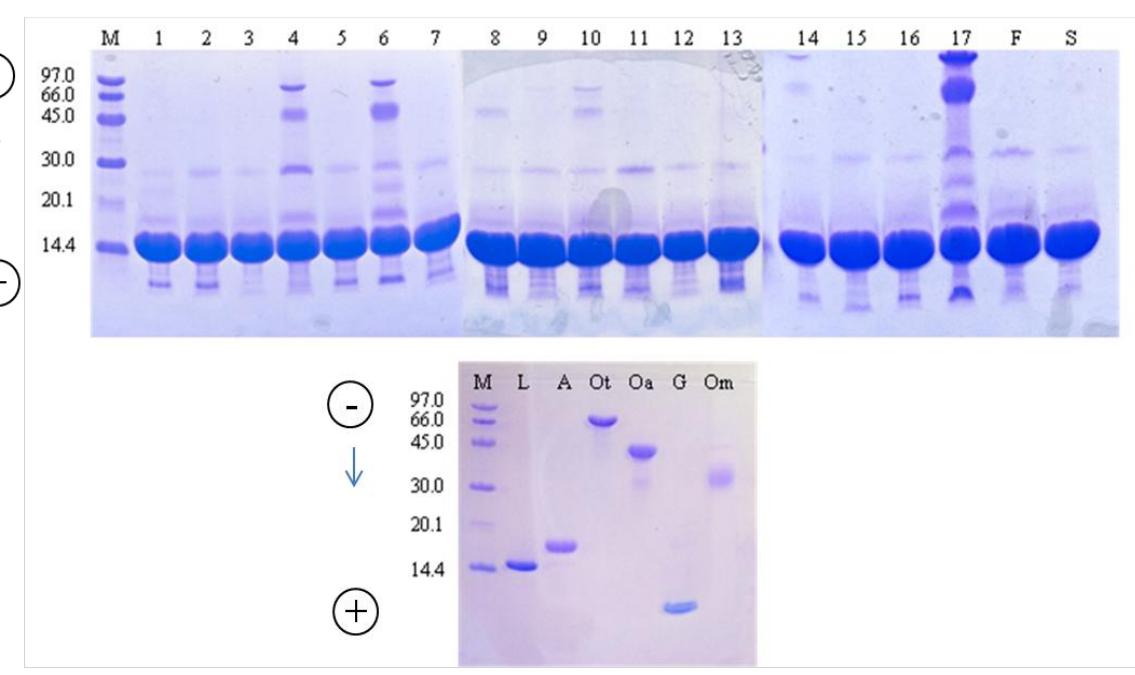
Figure 1. Sodium dodecyl sulphate (SDS) gel electrophoresis of commercial lysozyme preparations. Lane M: molecular weight markers; Lane from 1 to 17: lysozyme samples; F: FIP lysozyme standard; S: Sigma-Aldrich lysozyme; L: lysozyme; A: avidin; Ot: ovotransferrin; Oa: ovalbumin; G: gallin; Om: